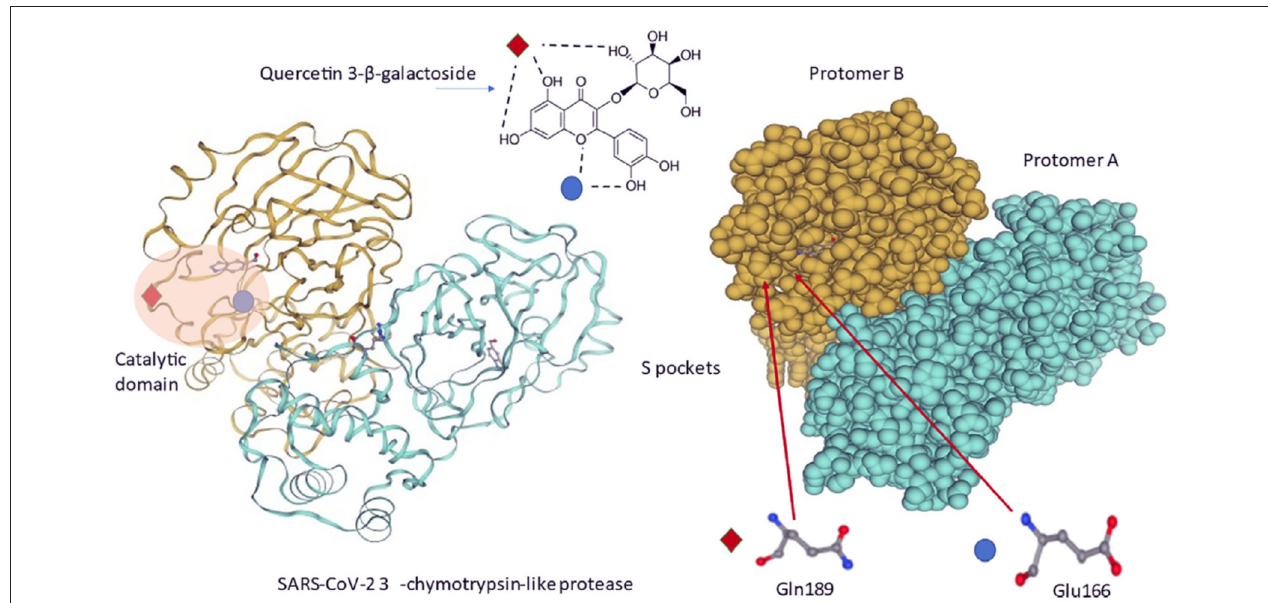
FIGURE 3 | Molecular interactions between quercetin-3- β -galactoside and SARS-CoV-2 3CLpro. Quercetin-3- β -galactoside forms hydrogen bonds specifically with Gln189 and Glu166 amino acids located inside a specific pocket hollowed in 3CLpro surface (70).